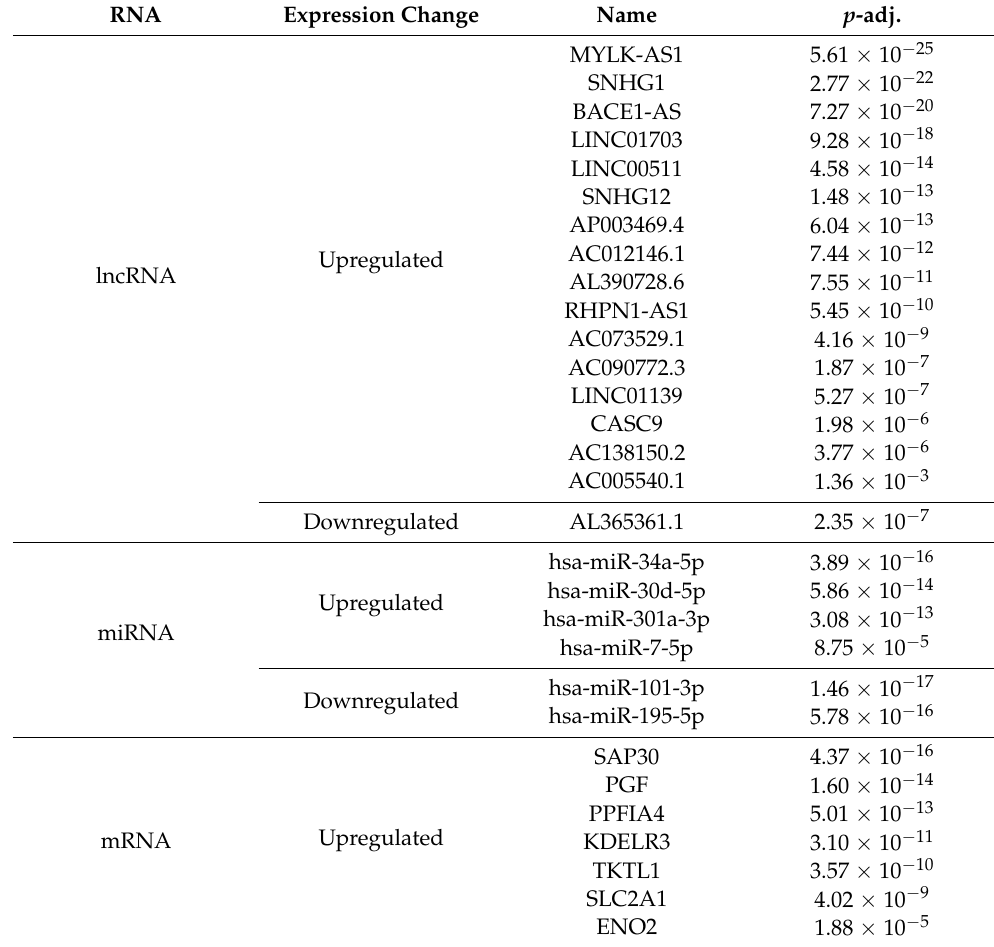
Table 1. Seven HR-DEmRNA-os, six DEmiRNA-os, and 17 DE-lncRNA-os in a hypoxia-related prognostic ceRNA network. RNA Expression Change Name p